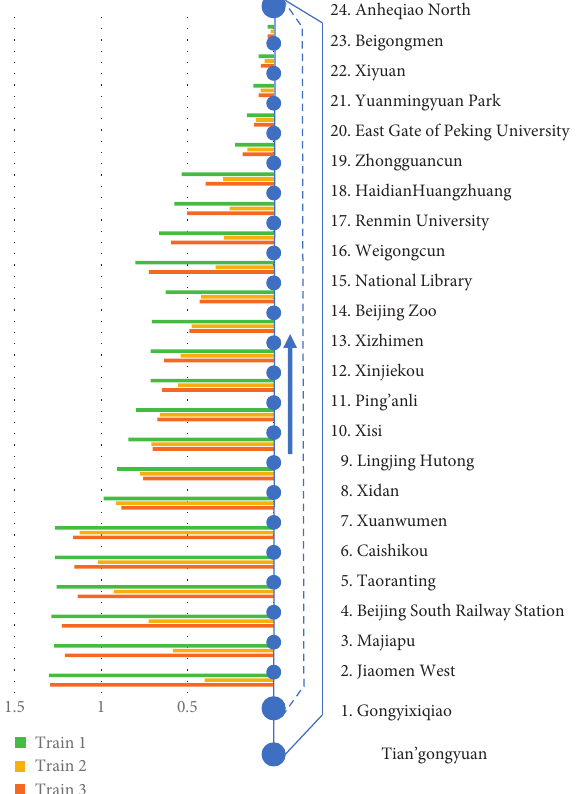
Figure 6: Operation loop of line 4-daxing in